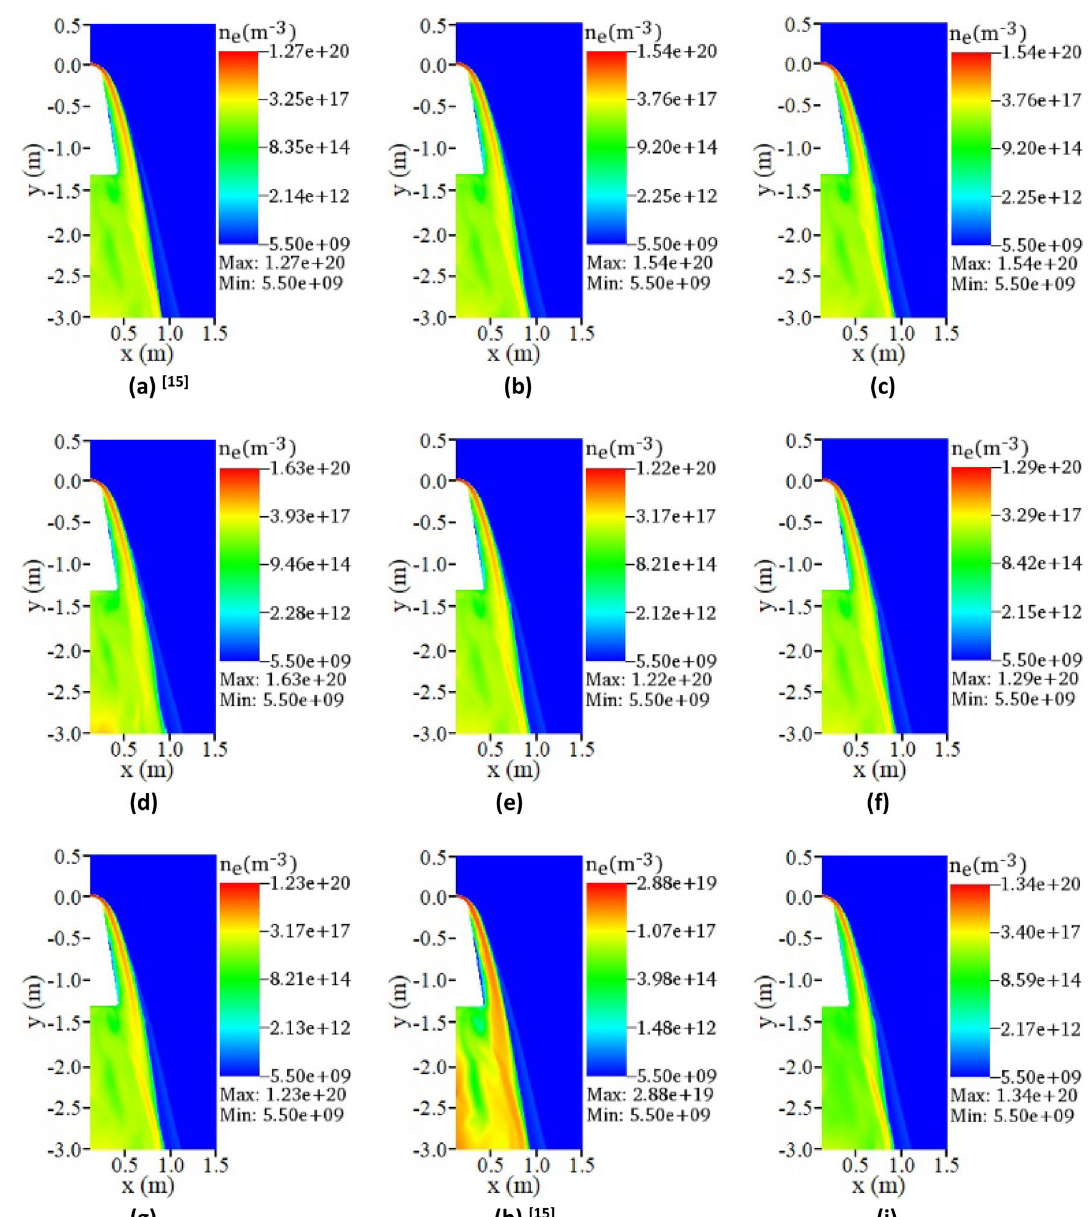
Figure 5. The electron number density distribution in Cases1-9 at 61 km. ( a ) case1 (f 1 = 1, f 2 = 1, f 3 = 1, f 4 = 1), ( b ) case2 (f 1 = 0.04, f 2 = 1, f 3 = 1, f 4 = 1), ( c ) case3 (f 1 = 10, f 2 = 1, f 3 = 1, f 4 = 1), ( d ) case4 (f 1 = 1, f 2 = 0.04, f 3 = 1, f 4 = 1), ( e ) case5 (f 1 = 1, f 2 = 10, f 3 = 1, f 4 = 1), ( f ) case6 (f 1 = 1, f 2 = 1, f 3 = 0.04, f 4 = 1), ( g ) case7 (f 1 = 1, f 2 = 1, f 3 = 10, f 4 = 1), ( h ) case8 (f 1 = 1, f 2 = 1, f 3 = 1, f 4 = 0.04), ( i ) case9 (f 1 = 1, f 2 = 1, f 3 = 1, f 4 =